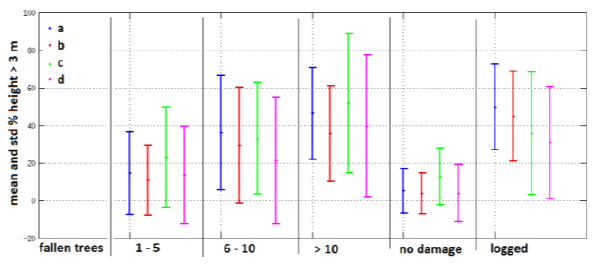
Figure 6. Mean percentage of height values above 3m in test squares of different damage groups. The test squares are coloured with different colour for each